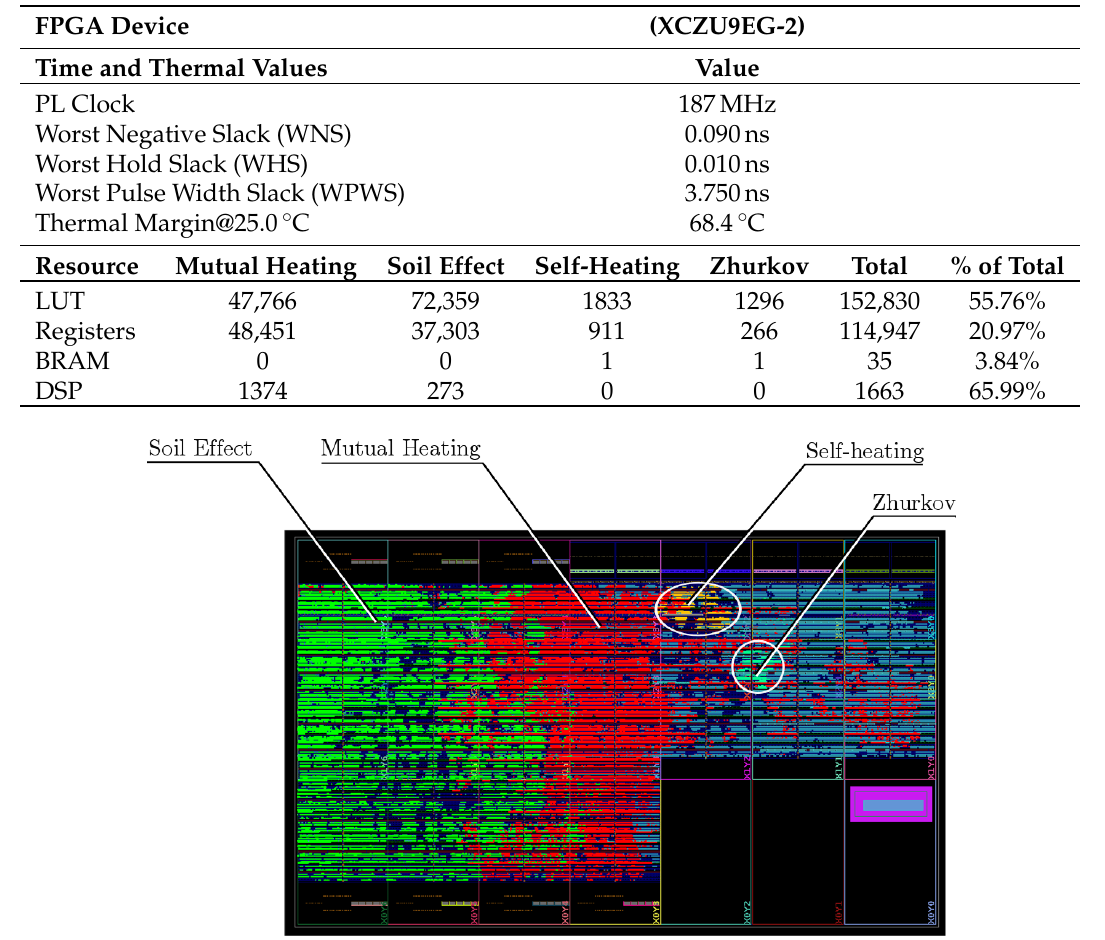
Figure 18. Distribution of the different model parts in the